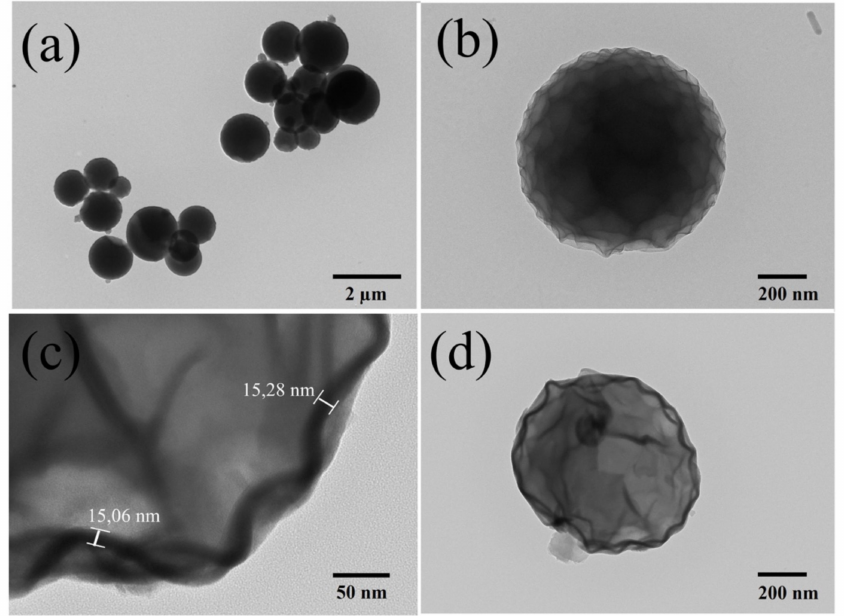
Figure 5. Transmission electron microscopy (TEM) images of ( a , b ) spherical PVP/Al 2 O 3 /Fe 2 O 3 particles and ( c , d ) hollow Fe 3 O 4